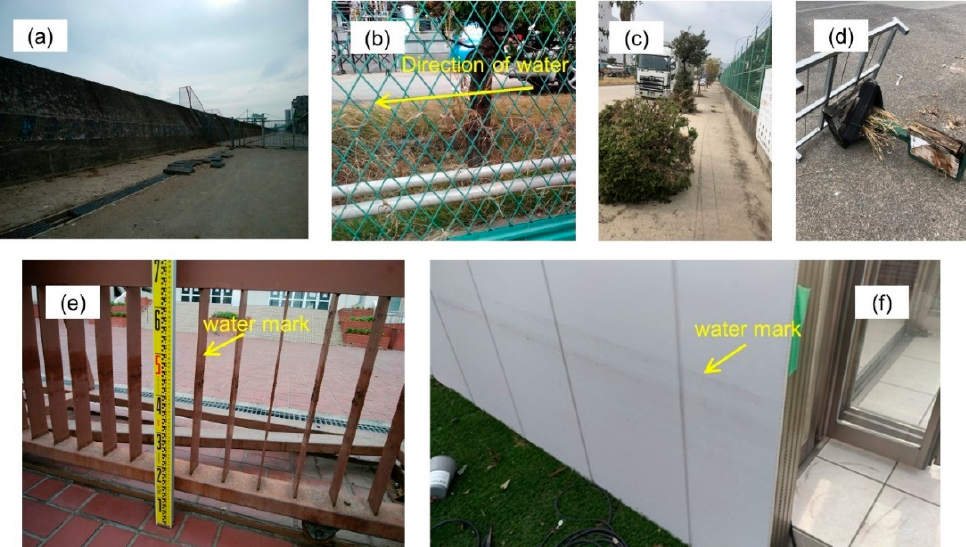
Figure 7. Photographs taken by the authors at Fukaehama town. ( a ) Coastal dike at Fukaehama town, ( b ) Survey Point F1 indicates that the direction of debris was towards the inland, ( c – d ) Presence of debris at Fukaehama town, ( e ) Survey Point F2 (watermark at school gate), ( f ) Survey Point F3 (watermark at a model house).